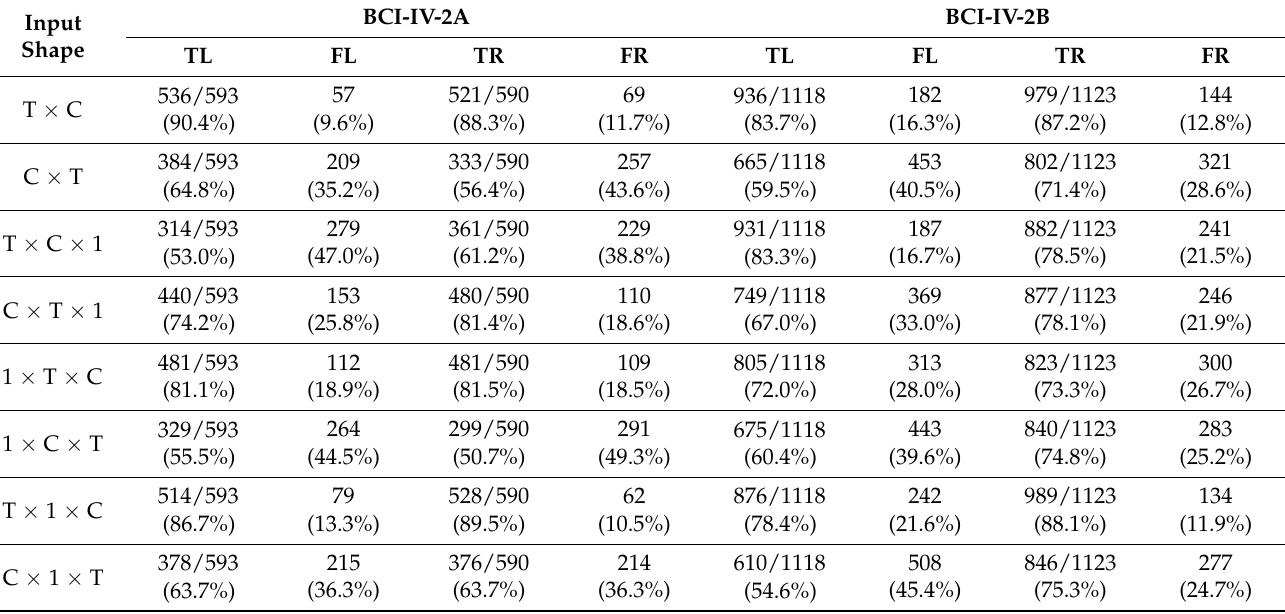
Table 4. Confusion Matrix Values for BCI-IV-2A and BCI-IV-2B.